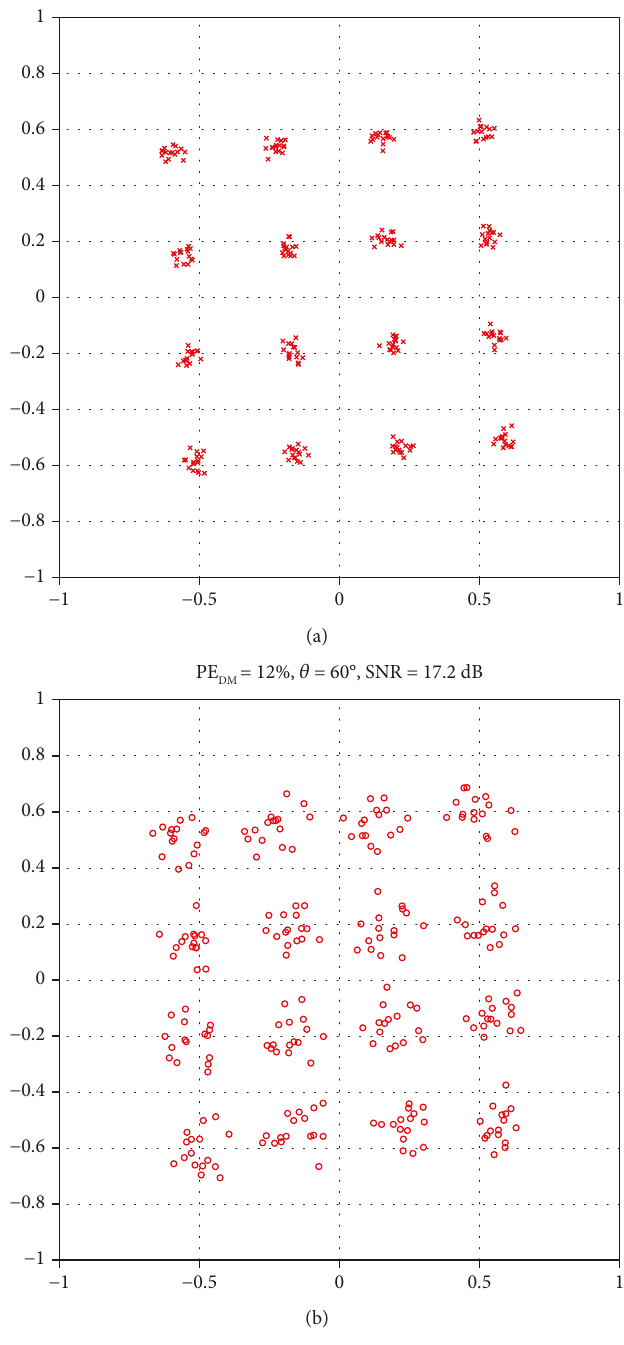
21 mn in the vector